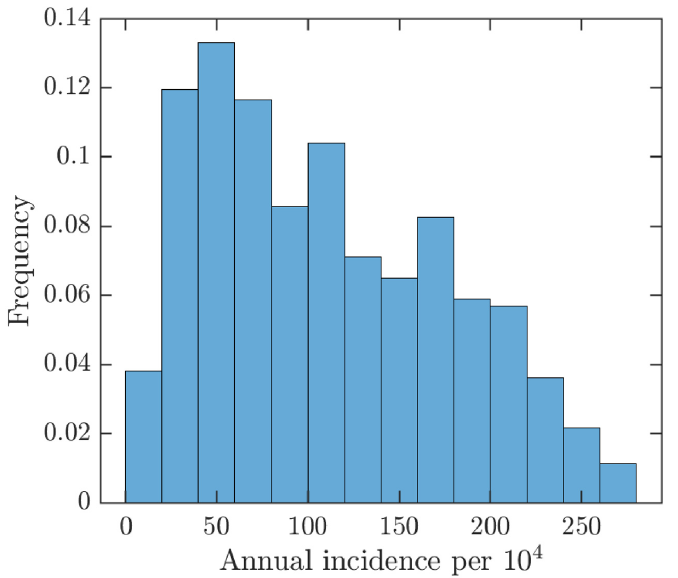
Fig 20. Uncertainty analysis for the MPX annual incidence per 10 4 unvaccinated population (the average is approximately 110).